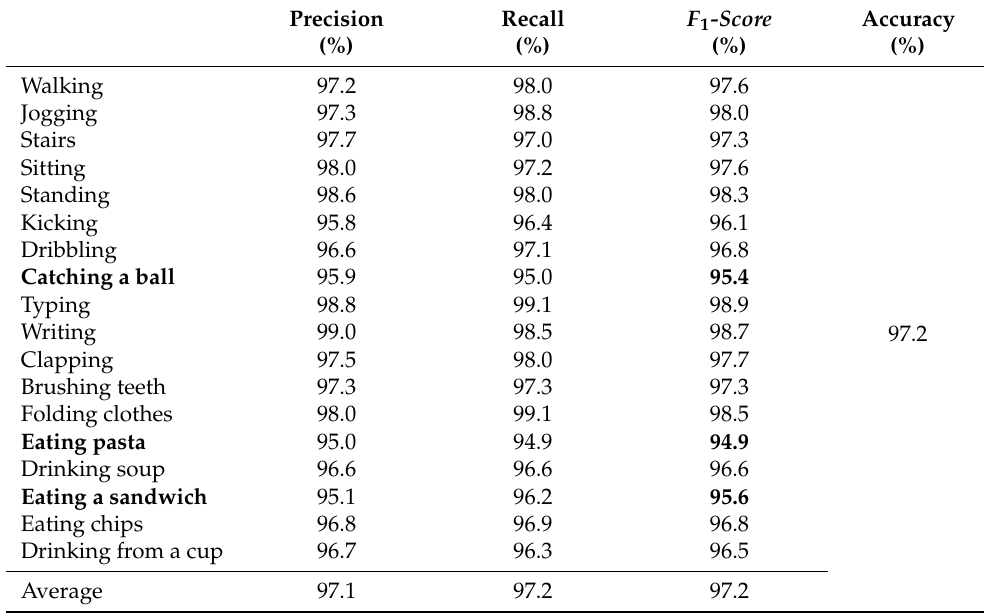
Table 3. The performances of the MPNN with the BP algorithm for 18 types of physical activities.